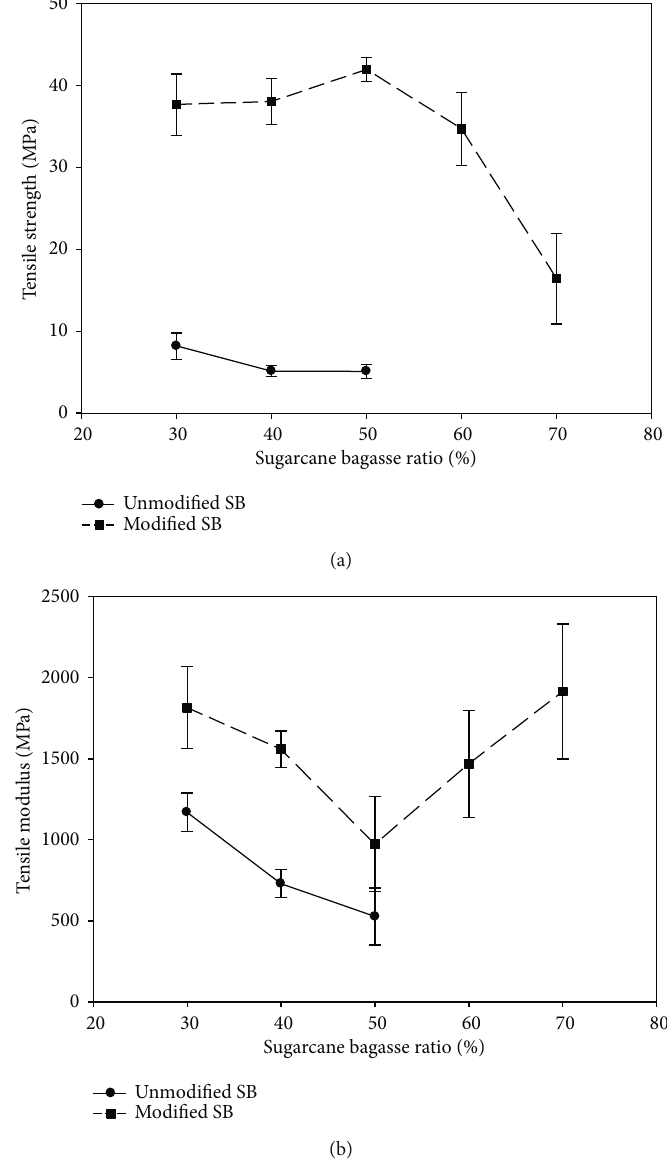
Figure 11: Tensile properties of PPG 700 elastomers: (a) tensile strength and (b) tensile